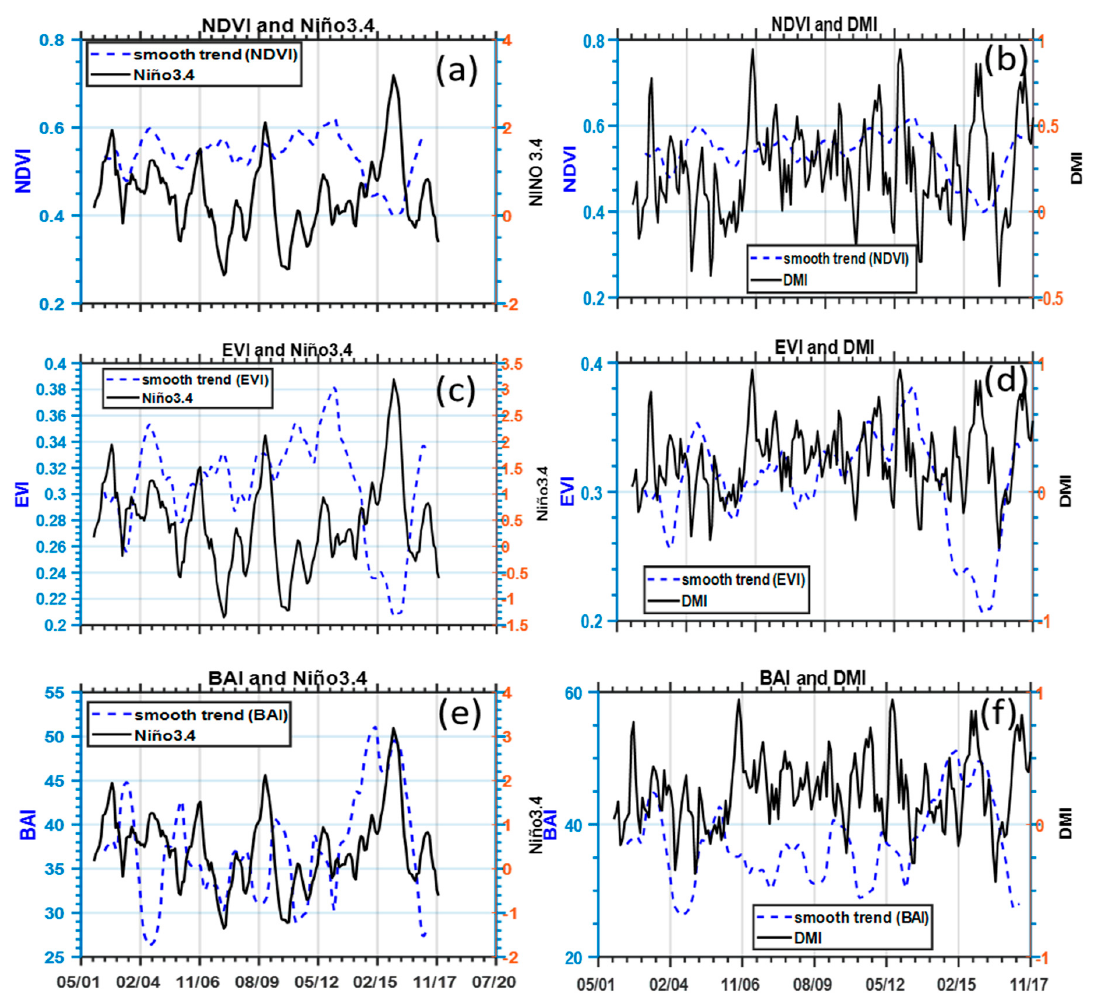
Figure 6. The ( a , b ) NDVI, ( c , d ) EVI and ( e , f ) BAI (blue dashed line) 12-month smooth trends versus Niño3.4 (left panels) and DMI (right panels) for the period from 2002 to 2017 for the HiP. The DMI was highly variable compared to the Niño3.4 climatic forcer throughout the study period, with several distinctive positive DMI values that reached a maximum of just below 1.0.